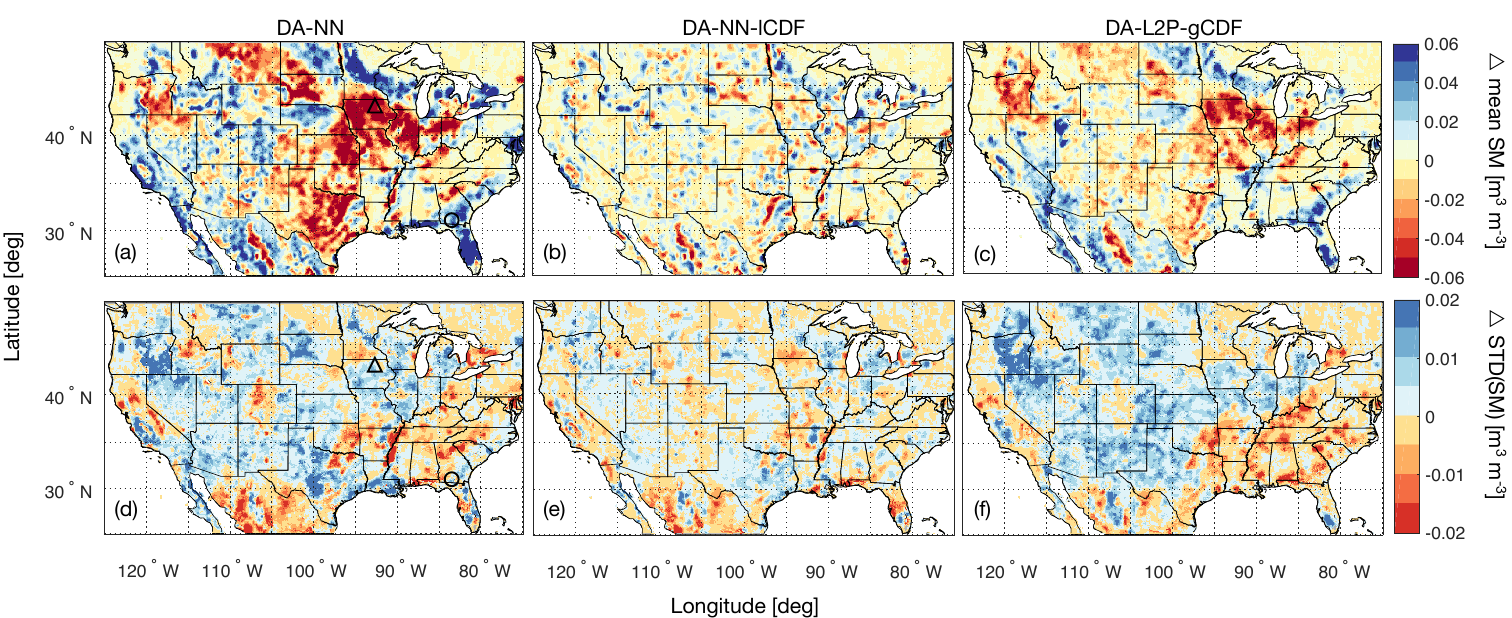
Figure 1. Average soil moisture difference—computed as data assimilation (DA) minus OL for the period April 2015 to March 2017—for the: ( a ) DA-NN; ( b ) DA-NN-lCDF; and ( c ) DA-L2P-gCDF experiments. Red colors indicate that the assimilation decreases the mean soil moisture with respect to the OL. Panels ( d – f ) are the same, but for the difference of the standard deviation with respect to the OL. Red colors indicate that the assimilation decreases the variability relative to the OL. Panels ( a ) and ( d ) also show the location of the South Fork (triangle) and Little River (circle) watersheds discussed in the